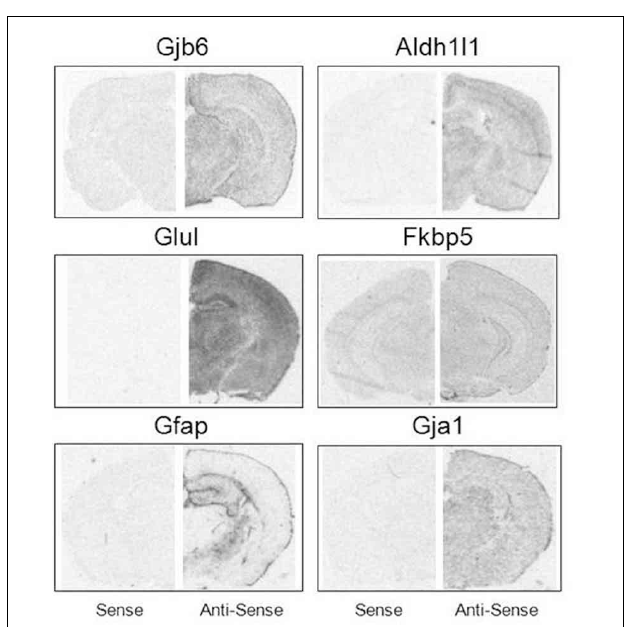
FIGURE 1 | Specificity of mRNA in situ hybridization probes. Sense ( Left ) and antisense ( Right ) comparisons of ISH probe signal under matched exposure times per